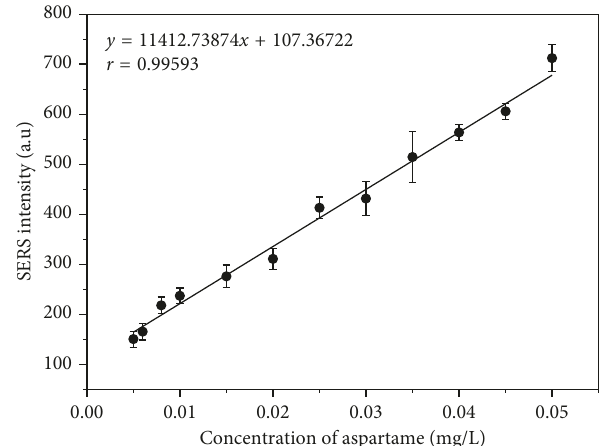
Figure 7: SERS measurement of aspartame solution by the plasma cavity. Lines a to i denote concentrations of 0, 0.004, 0.006, 0.008, 0.01, 0.02, 0.2, 2, and 20mg/L, respectively.